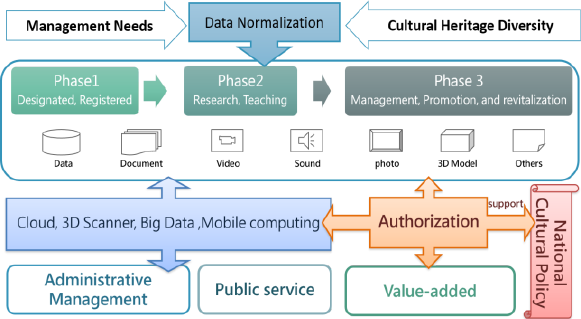
Figure 2. Conceptual diagram of the full life cycle of cultural heritage